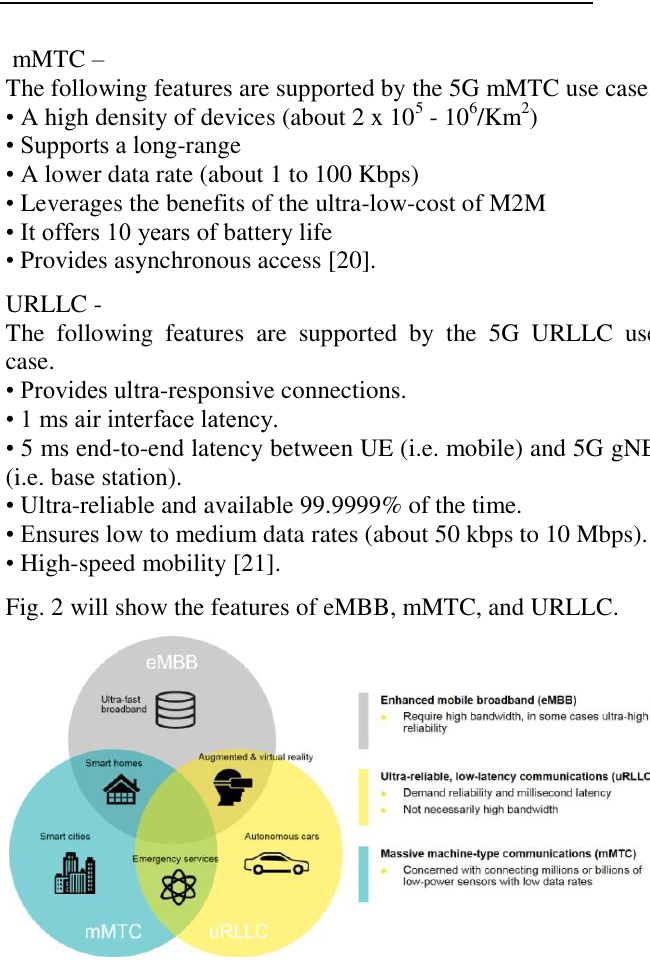
Fig 2. Features of eMBB, mMTC, and